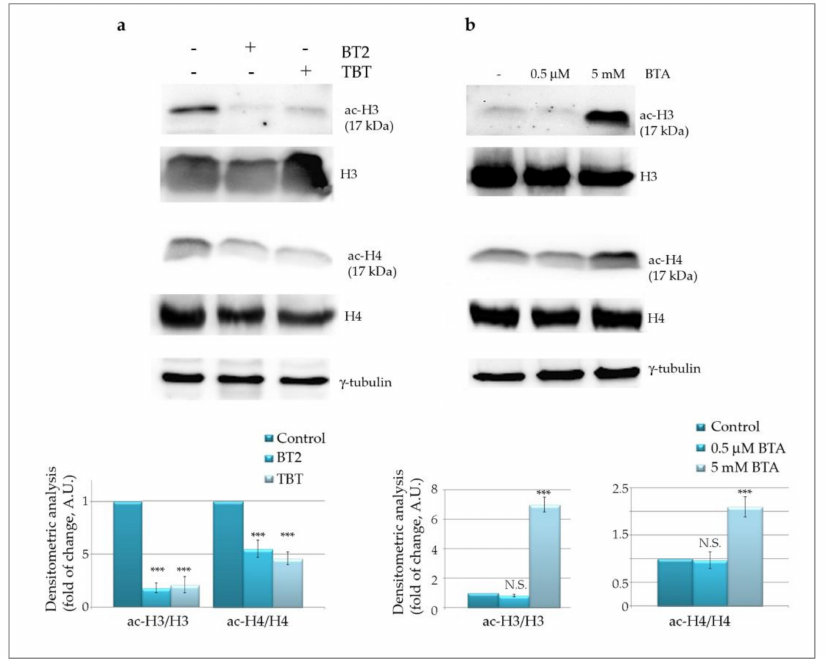
Figure 6. Tributyltin(IV) butyrate (BT2) remarkably reduces histone acetylation. Western blot analysis of acetylated-H3 and H4 histones after treatment for 48 h with 0.5 µ M BT2 and TBT ( a ) or 0.5 µ M and 5 mM butyric acid (BTA) ( b ) are shown. The ratio between acetylated histones and total histone levels was quantified. Representative blots of three independent experiments and densitometric analysis are shown. (***) p -value < 0.001 compared with untreated cells. N.S. = not